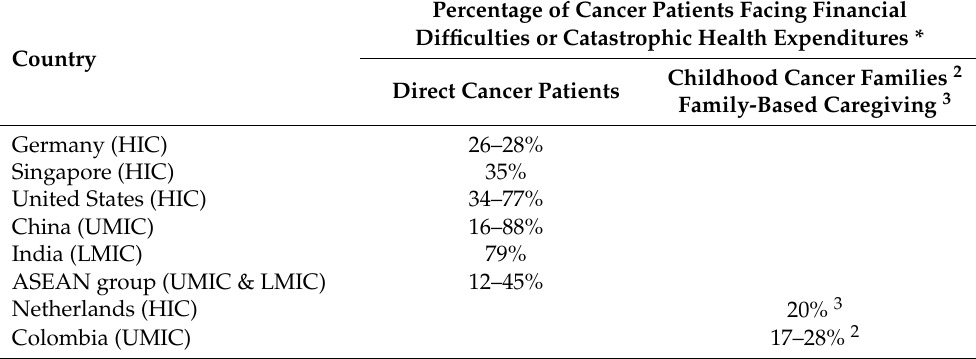
Table 2. Financial impact of cancer diagnosis on patients and their families in different countries.